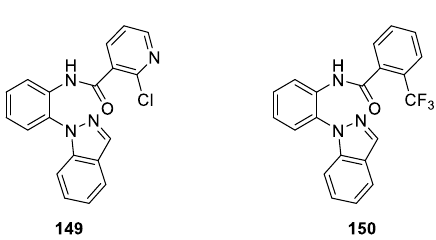
Figure 41. Chemical structures of 1 H -indazole derivatives 149 and 150 .